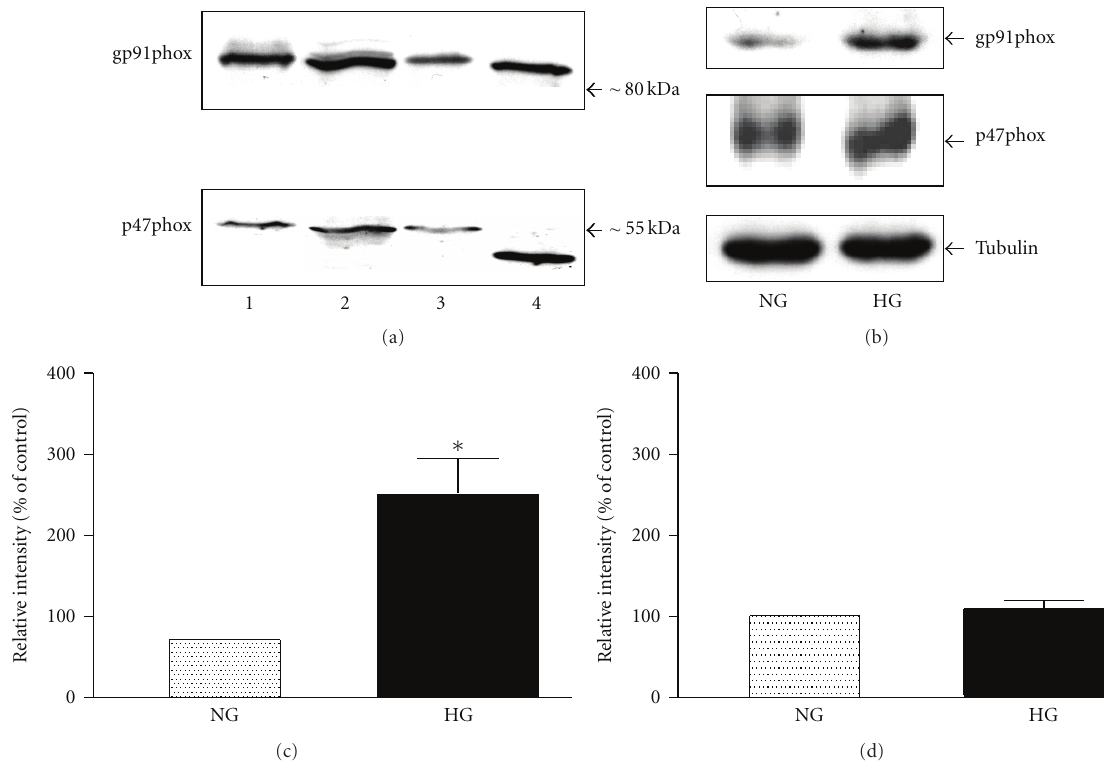
Figure 1: Retinal capillary pericytes express NADPH oxidase . Aliquots of total cellular protein were separated by SDS-PAGE, electrophoret- ically transferred onto Hybond-ECL membranes. Blots were probed with (a) anti-gp91phox antibody and anti-p47phox antibody. Protein antibody complexes were detected using secondary antibody conjugated with horseradish peroxidase and the ECL detection system. Lane 1: BRP, lane 2: BREC (bovine retinal capillary endothelial cells), Lane 3: HUVEC (human umbilical vein endothelial cells), and lane 4: U937 cells (human leukocytes). (b) Representative Western blots of gp91phox, p47phox and tubulin. (c) Expression of gp91phox protein expression in BRP exposed to high glucose (HG, 25mM) for 48 h. Densitometric ratio (intensity gp91phox immunoreactive band/intensity of the tubulin immunoreactive band) is expressed as % of normal glucose (NG, 5.6mM). (d) Expression of p47phox protein expression in BRP exposed to high glucose (HG, 25 mM) for 48 h. Densitometric ratio (intensity of p47phox immunoreactive band/intensity of the tubulin immunoreactive band) is expressed as % of normal glucose (NG, 5.6mM). Data are represented as Means ± SEM of 3-4 separate experiments. ∗ P < . 05 versus